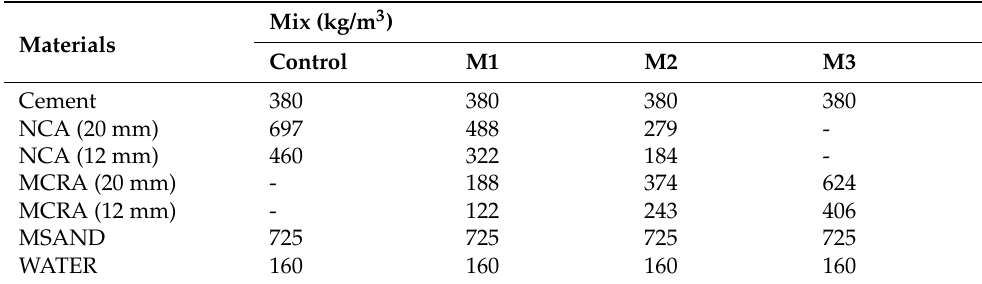
Table 3. Composition of the concretes